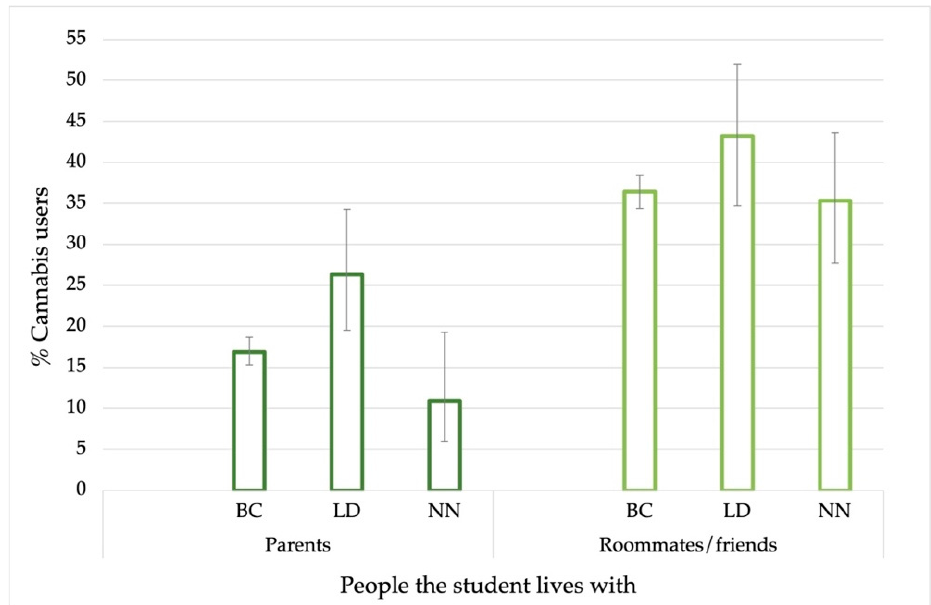
Figure 4. Cannabis use in the usual residence according to who the students lived with, during the three study periods (BC: Before COVID-19, LD: Lockdown, NN: New Normal). Error bars show a 95% confidence interval on the prevalence.